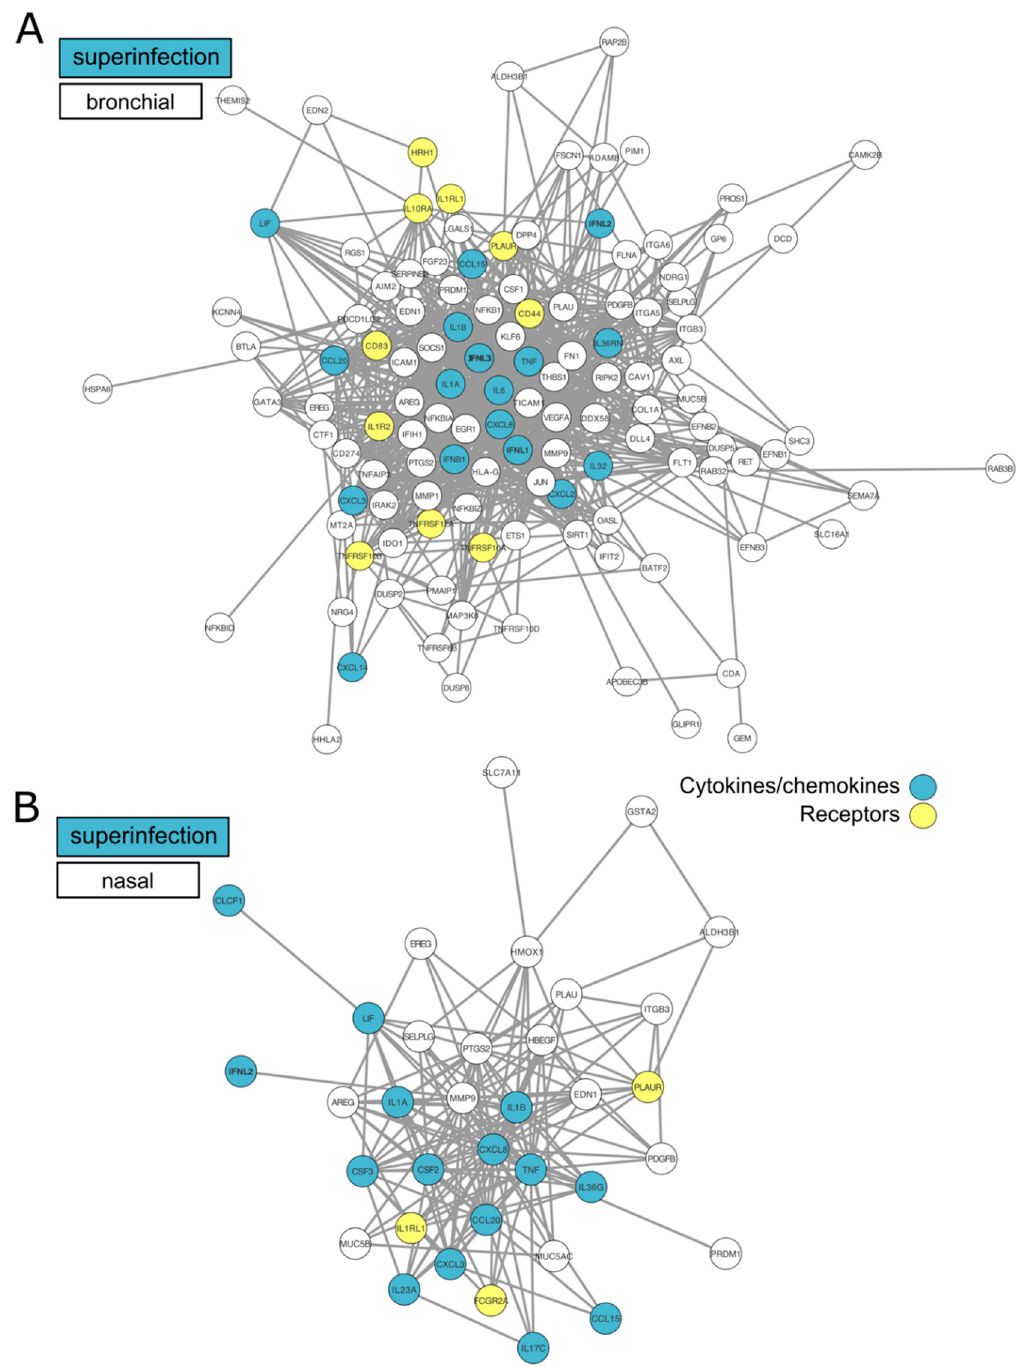
Figure 3. ( A ) and ( B ) Network visualization of immunity-associated proteins in superinfected HAE. We selected the 76 and 191 genes significantly di ff erentially expressed (vs. CoV) in our study (respectively in nasal ( A ) and bronchial ( B ) HAE) associated with the Reactome “Interleukin-10 Table 0395. and the Gene Ontology term “immune system process” (GO:0002376). The circles indicate genes modulated in our study in the superinfection context. The predicted associations are materialized by the dark lines. Cytokines / chemokines are highlighted in blue and receptors in